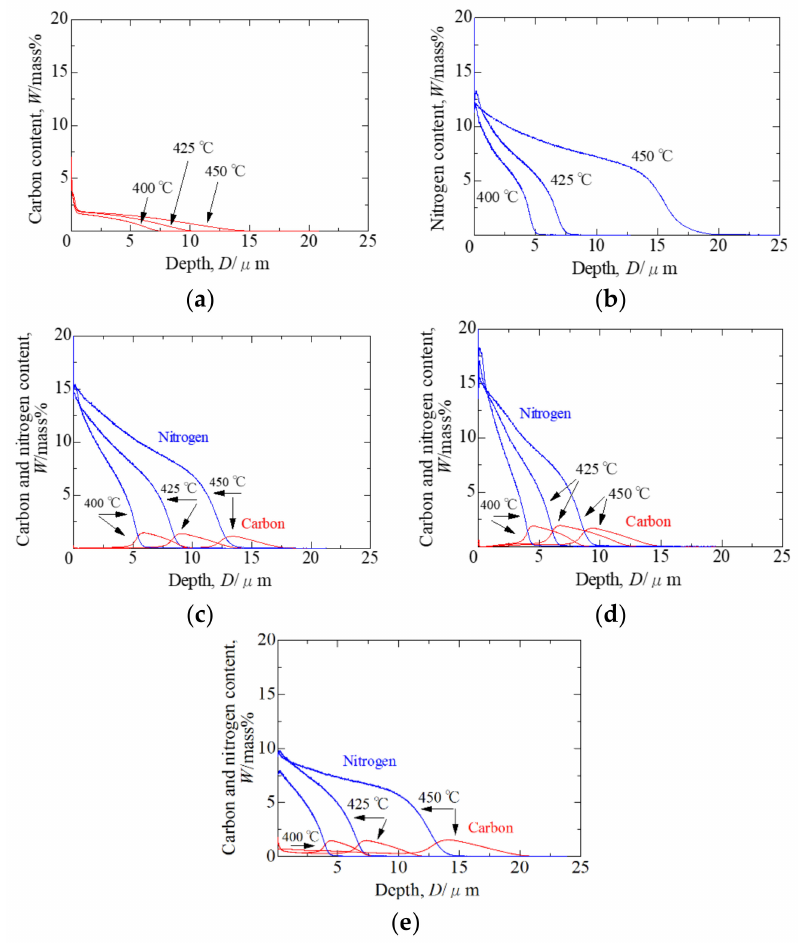
Figure 6. Carbon and nitrogen depth distributions of the S-phase layers on cold-sprayed AISI 316L coatings obtained at 400, 425 and 450 ◦ C by ( a ) carburizing for 4 h, ( b ) nitriding for 4 h, ( c ) C0.5 h → N3.5 h, ( d ) C2 h → N2 h, and ( e ) (C+N)4